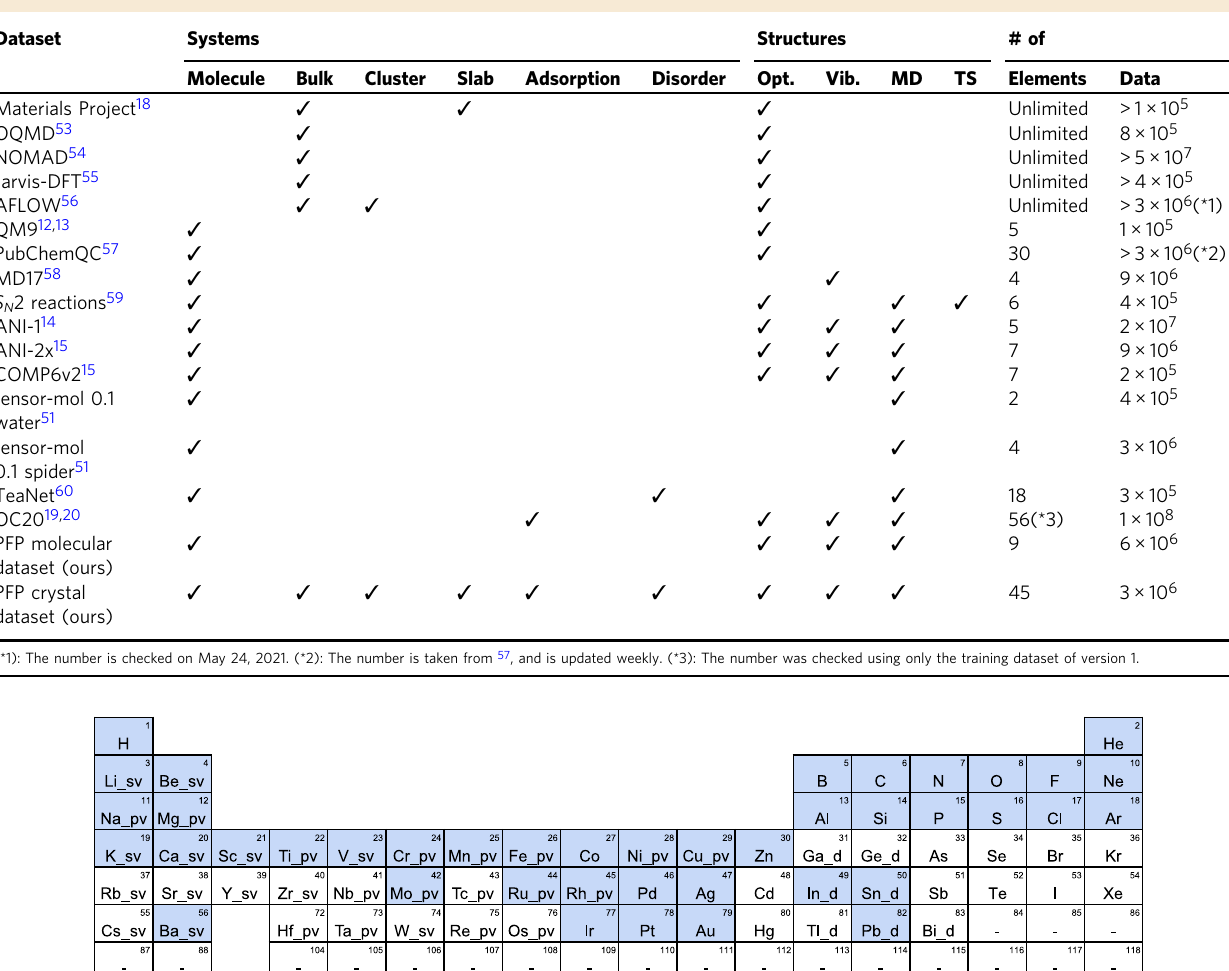
Table 2 Comparison of DFT calculated datasets that can be used to train the neural network potential.